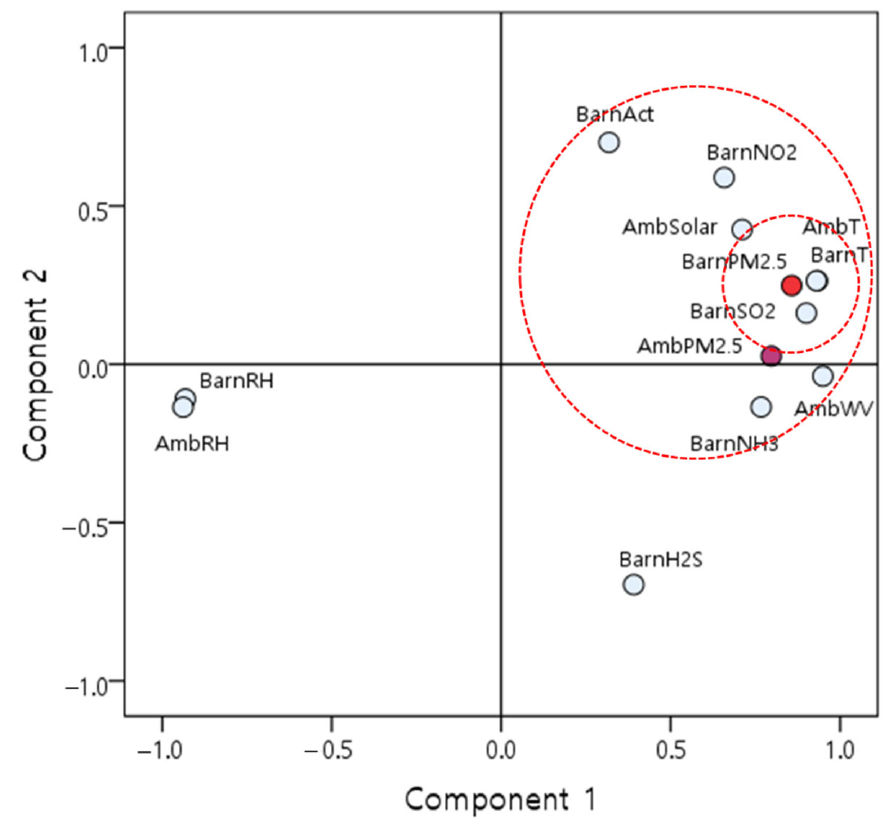
Figure 8. Principal component analysis (PCA): results rotated by Varimax to capture factors influencing PM 2.5 emission in 24 h. Components 1 and 2 explain 67.1% and 10.9% of the variance, re ‐